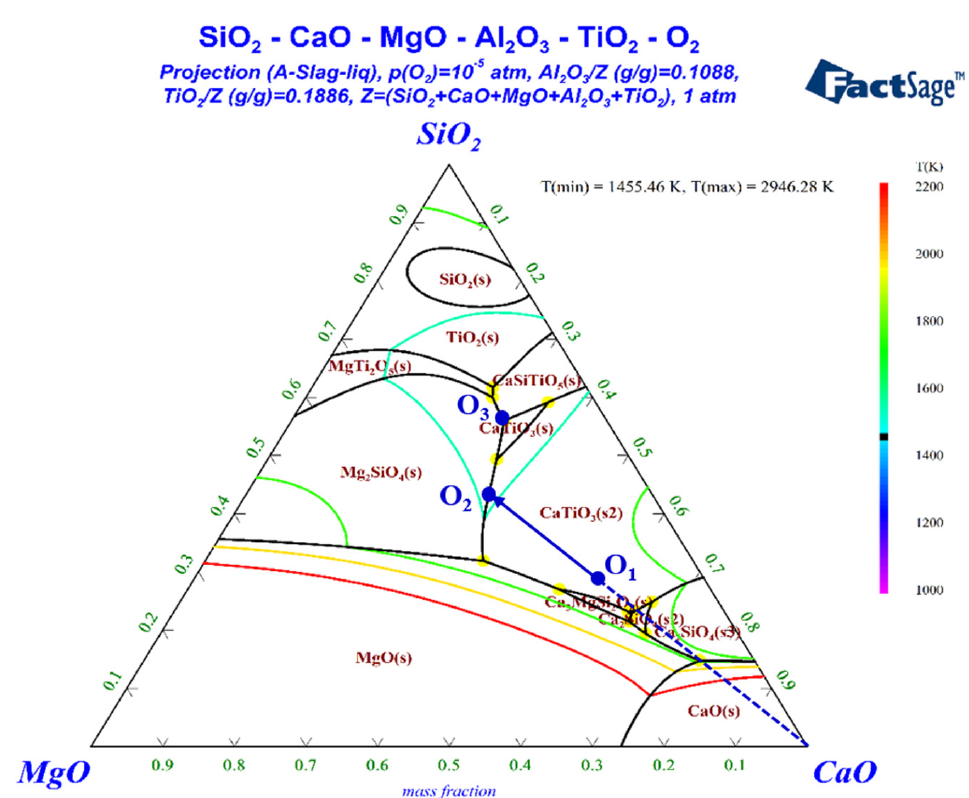
Figure 8. Phase diagram of SiO 2 -CaO-MgO-(Al 2 O 3 -TiO 2 ).